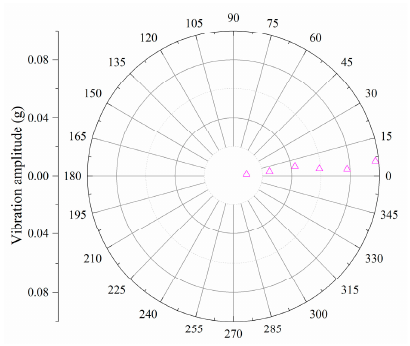
Figure 16. Vertical polar diagram of counterweight.